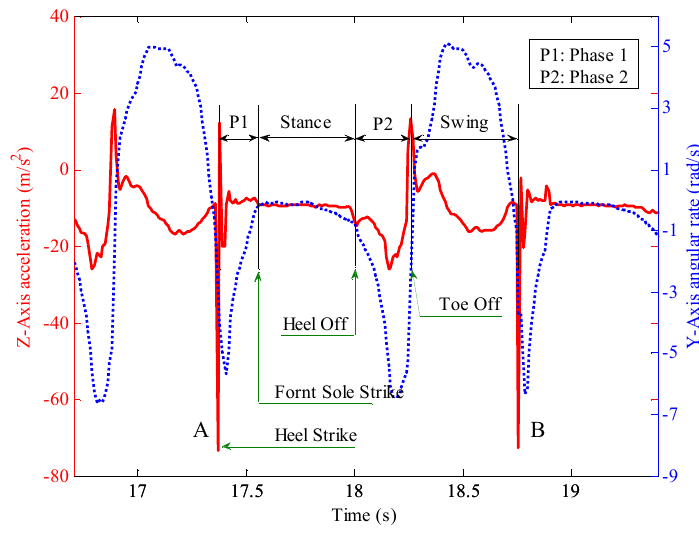
Figure 3. Pedestrian gait cycle.